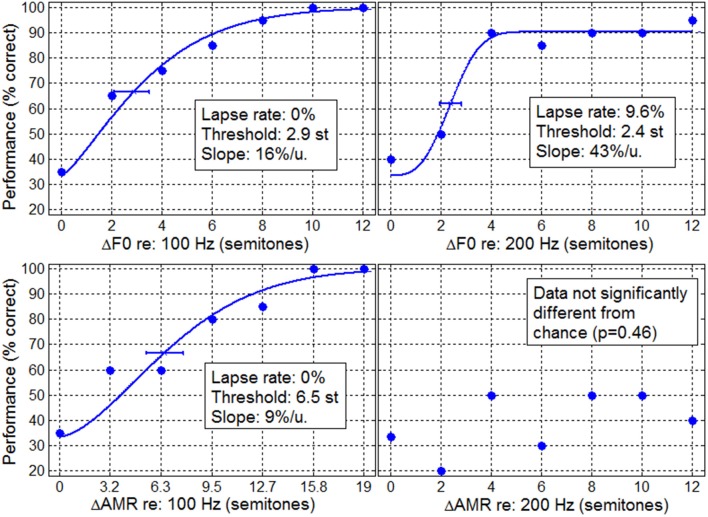
Typical example of performance data for an implanted child in the F0 discrimination task (top panels) and in the AMR discrimination task (bottom panels) at 100 Hz (left) and 200 Hz (right). Lines represent the psychometric fits obtained from the maximum likelihood technique from which lapse rate, threshold, and slope were extracted.